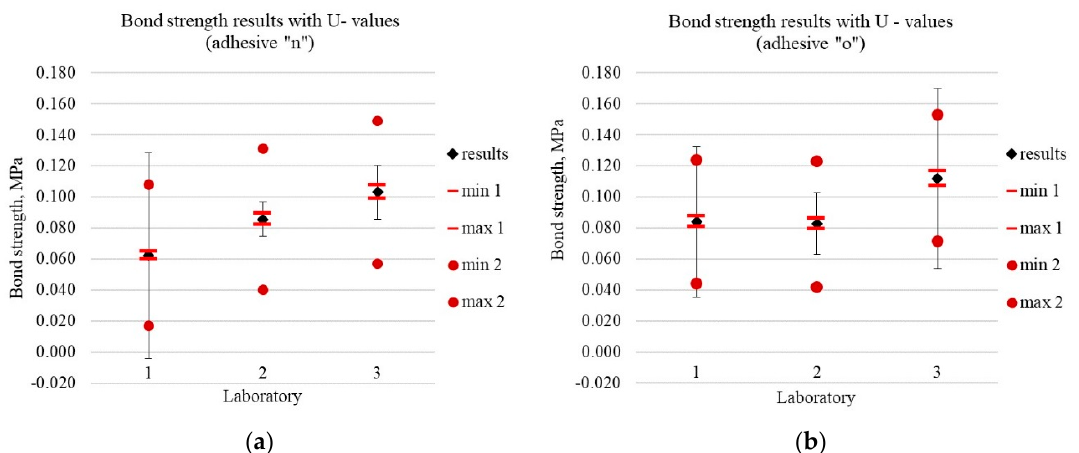
Figure 4. Bond strength results with U value for three laboratories (1–3) and two materials ( a ) adhesive ‘n‘; ( b ) adhesive ‘o’. Black error bars are based on actual standard deviation (approach II). Points min 1 and max 1 are 95% coverage intervals obtained in approach I (only B-uncertainty of F and D v alues), points min 2 and max 2 are 95% coverage intervals obtained by the Monte Carlo method in approach IV, where reproducibility standard deviation obtained from inter-laboratory comparisons was used.